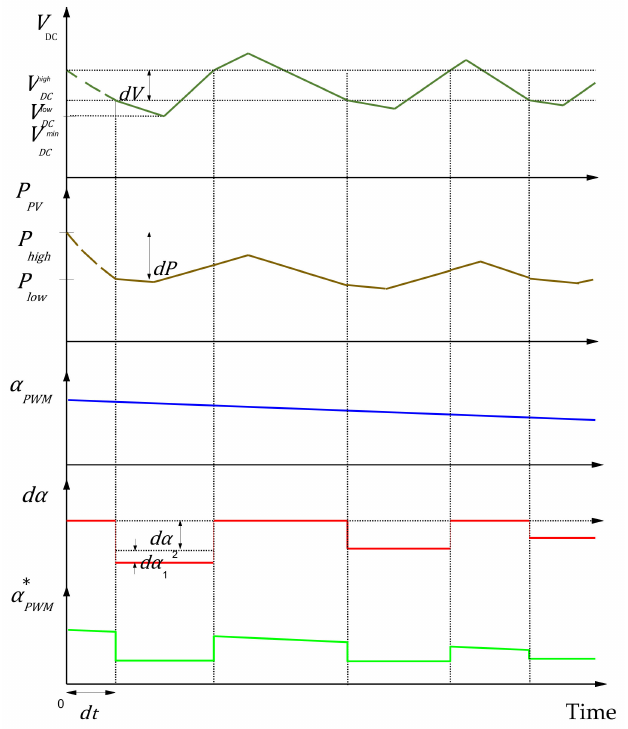
Figure 5. DC voltage, active power, PWM phase shift, HBC output, and overall phase